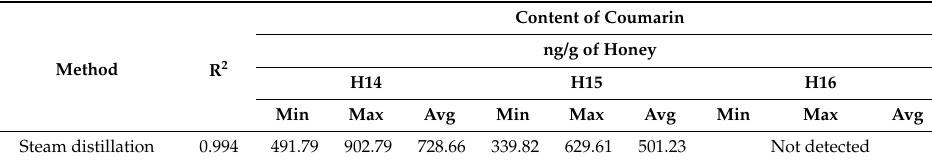
Table 3. Coumarin content in Polish sweet yellow clover